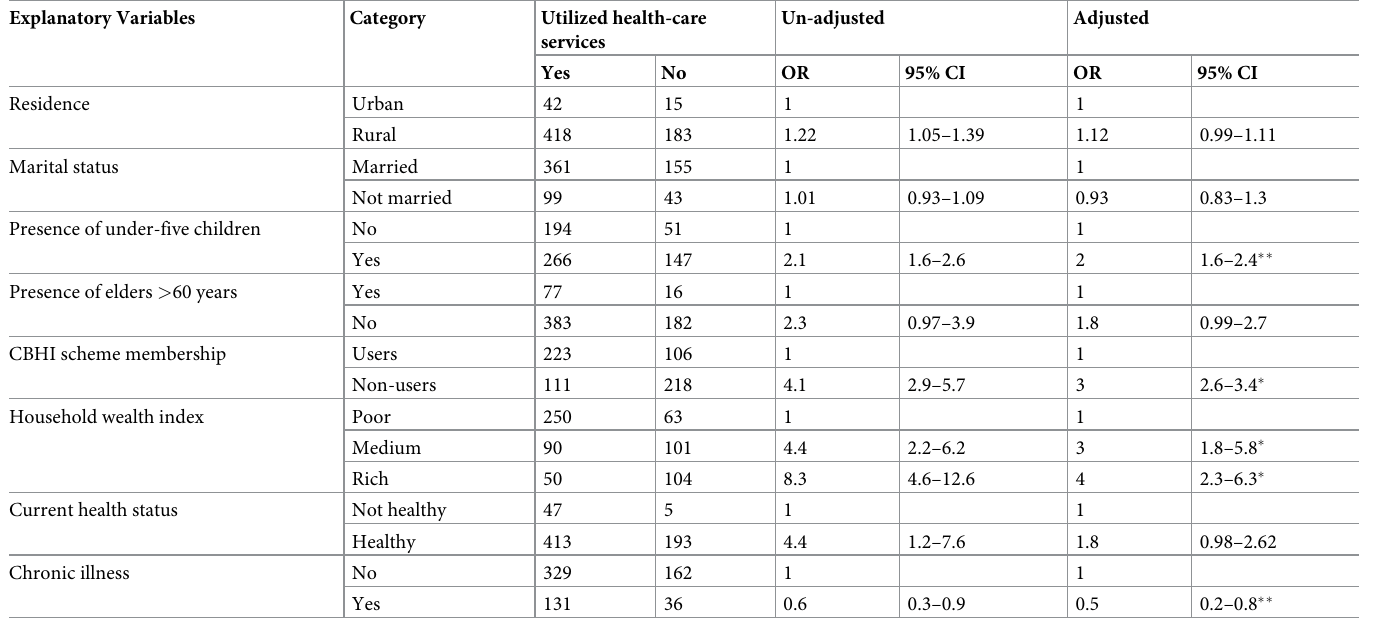
Table 3. Factors associated with health care utilization of respondents in South Gondar Zone, Northwest Ethiopia, 2021 (n = 658).